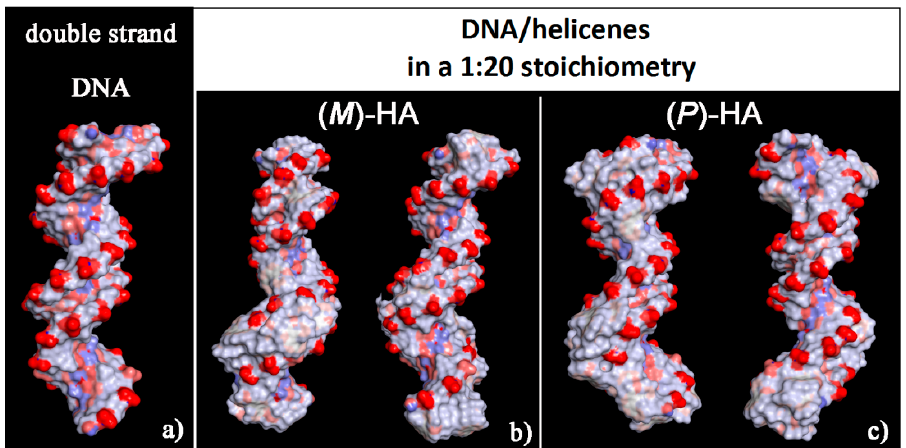
Figure 6. Solvent-accessible surface area colored by atoms charge for the optimized geometries of double-stranded DNA as data from Protein Data Bank on the left ( a ), of ( M )-HA ( b ) and ( P )-HA on the right ( c ) obtained after energy minimization of the conformation assumed by the system at the end of MD run considering enantiopure compounds in a 1:20 stoichiometry. Atoms that are partially negatively charged are in red, partially positively charged atoms in blue and apolar groups of atoms in white.